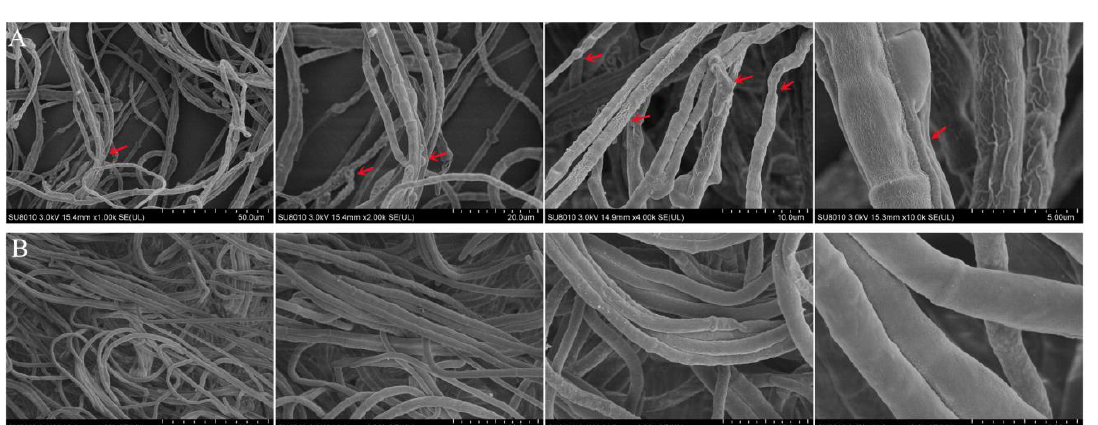
Figure 9. Scanning electron micrograph analysis of A. alternata mycelia ultrastructure morphology. ( A ) Mycelia treated with 200 mL L − 1 aseptic filtrate after 12 h. ( B ) Untreated mycelia after 12 h. Note: The position indicated by the red arrows indicates the curved, deformed, or coarse hyphae.